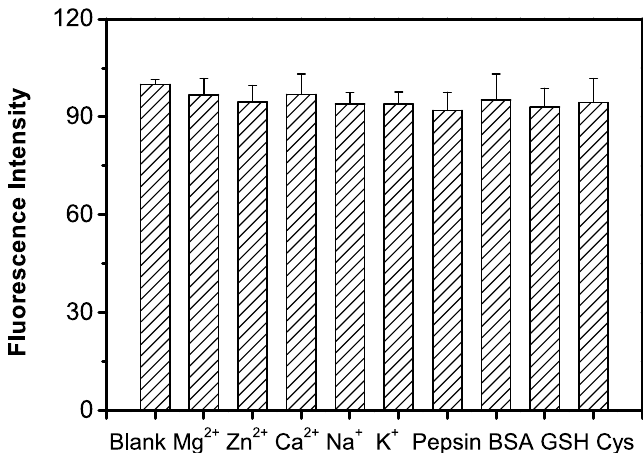
Figure 7. Effect of glucose concentration on I/I 0 in the presence of potential interferents.